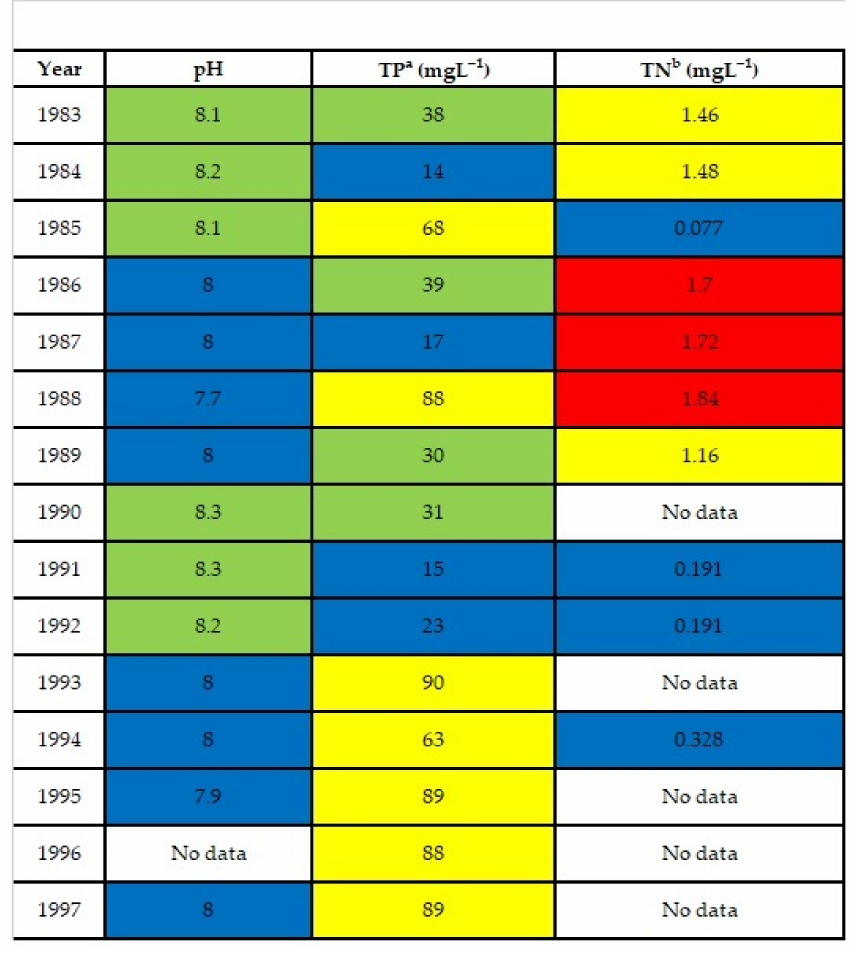
Figure 5. Average values of water quality parameters of the studied surface water body and chemical conditions typology as stated by ECOFRAME and MED-GIG system (data were provided by HMRDF 2019, a Criteria given by ECOFRAME [15]; b Criteria given by Poikane